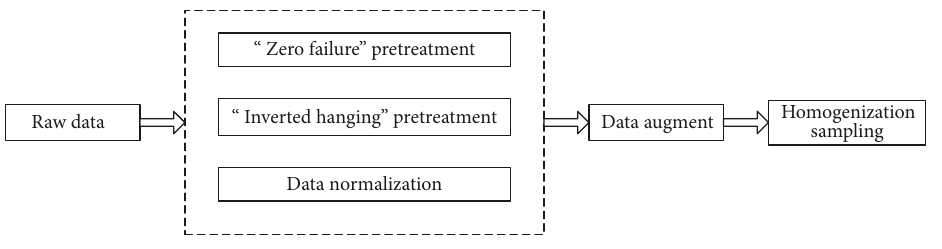
Figure 3: The process of data pretreatment and